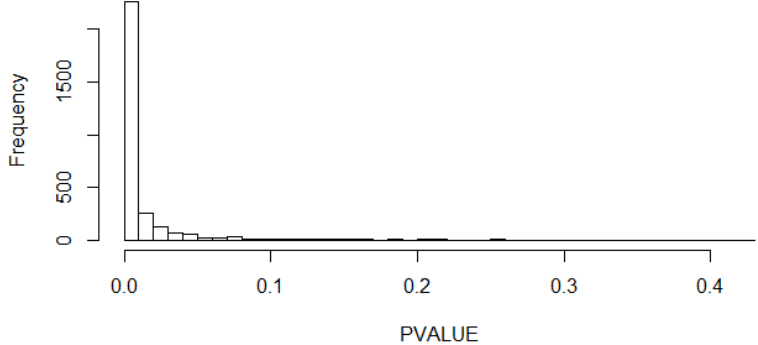
Figure 3. p -value histogram for the comparison between the daily and nightly segments.